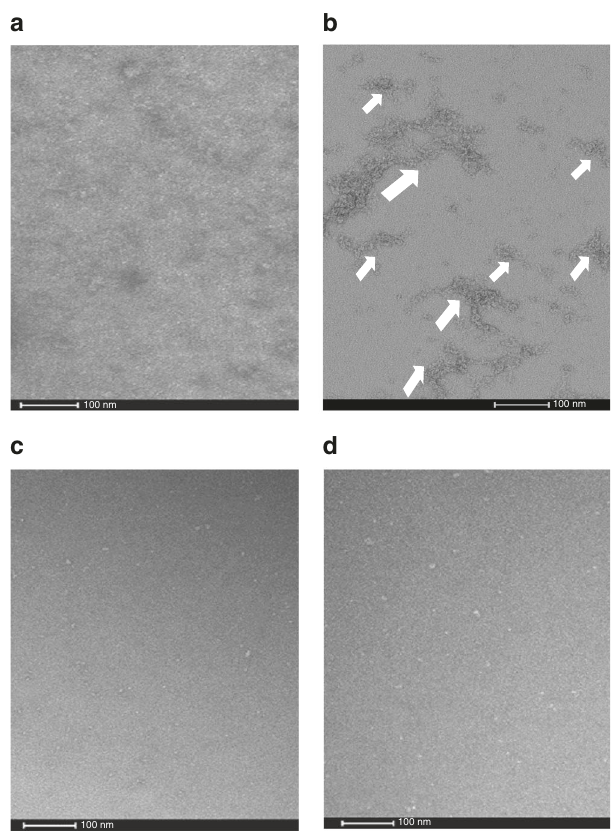
Fig. 6 Effect of POA on PanD WT and resistant mutant, non-POA binding PanD 127TRASC131 as visualized by electron microscopy. Electron micrograph of negatively stained PanD WT in the absence ( a ) and presence of 200 µ M POA ( b ). The comparison visualizes oligomer formation upon drug binding to PanD WT . The different sized white arrows indicate the different sizes of oligomers formed. Control experiment showing PanD 127TRASC131 mutant protein in the absence ( c ) and presence ( d ) of 200 µ M POA, demonstrating that the formation of aggregates by POA is speci fi c to the wild-type protein. Scale bars: 100 nm. These data show that POA causes oligomer formation of wild-type PanD but not of a POA- resistant mutant version of the protein. The experiment was carried out twice independently yielding the same results. These results are consistent with the corresponding results from dynamic light scattering experiments shown in Fig.